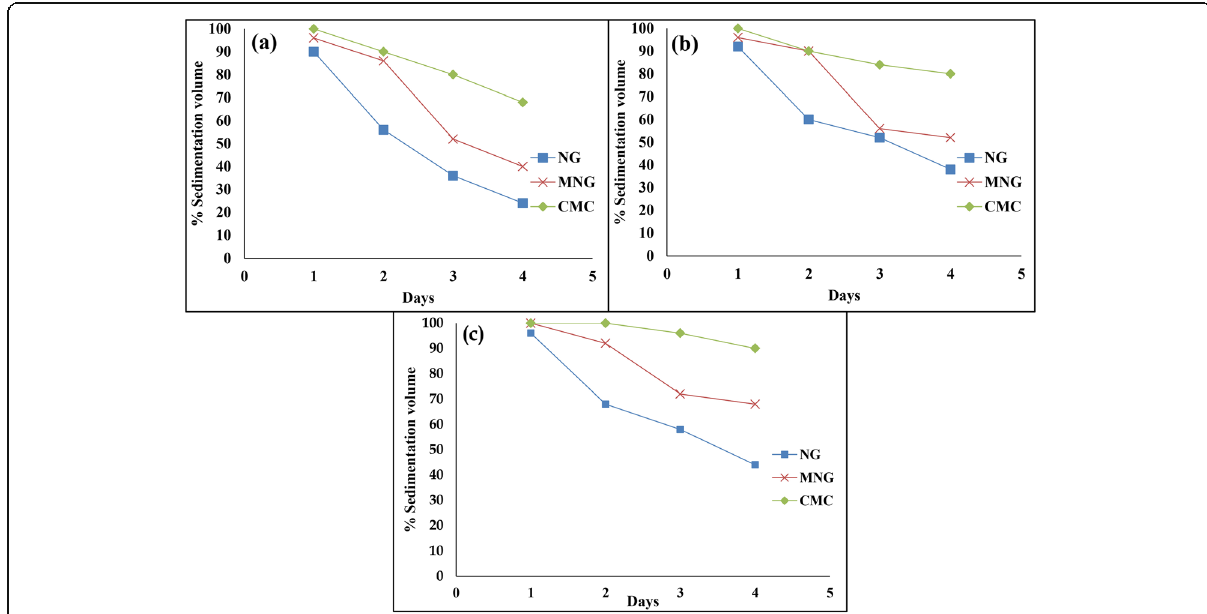
Fig. 3 Comparative sedimentation volume (%) of suspension using a 0.25%, b 0.5% and c 1.0% of NG, MNG and